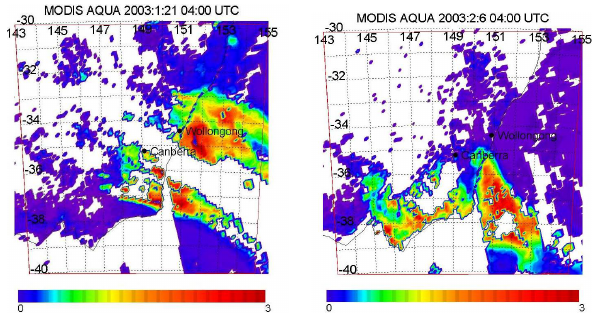
Fig. 1. Example images of MODIS product “MYD04” aerosol op- tical depth measurements over south-eastern Australia re-projected and plotted as maps. The Aqua overpass from 21 January 2003 is shown in the left-hand panel and the Aqua overpass from the 6th February is shown in the right-hand